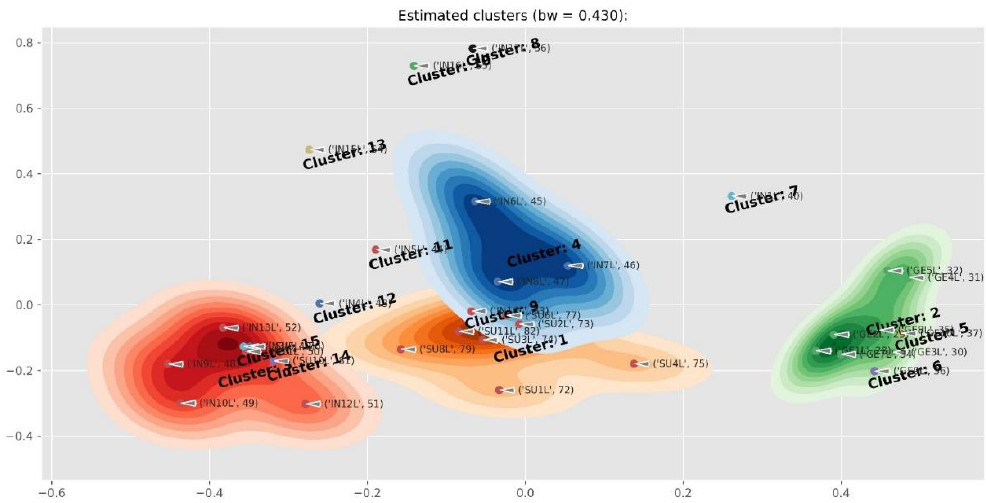
Figure 7. Cluster map of the Cyclopia intermedia (IN), C. genistoides (GE), and C. subternata (SU) leaf extracts with mangiferin and citric acid excluded, showing a separation of C. genistoides (green, cluster 2,5, and 6) and from C. subternata (orange, cluster 1) and C. intermedia (red, cluster 3,4) with some extracts forming additional clusters that appear to be based on geography/provenance/population.